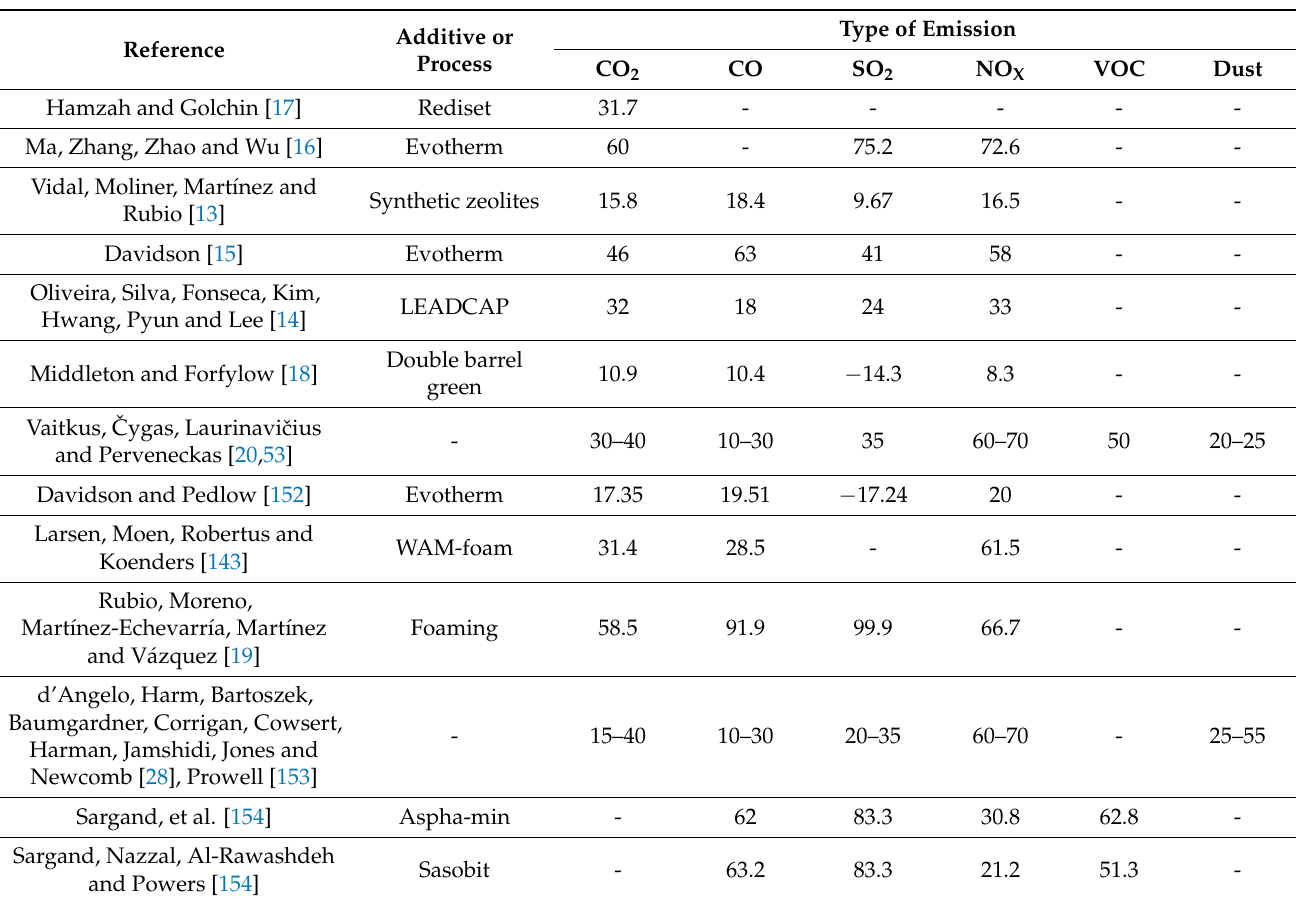
Table 7. The reduction in gas emissions,